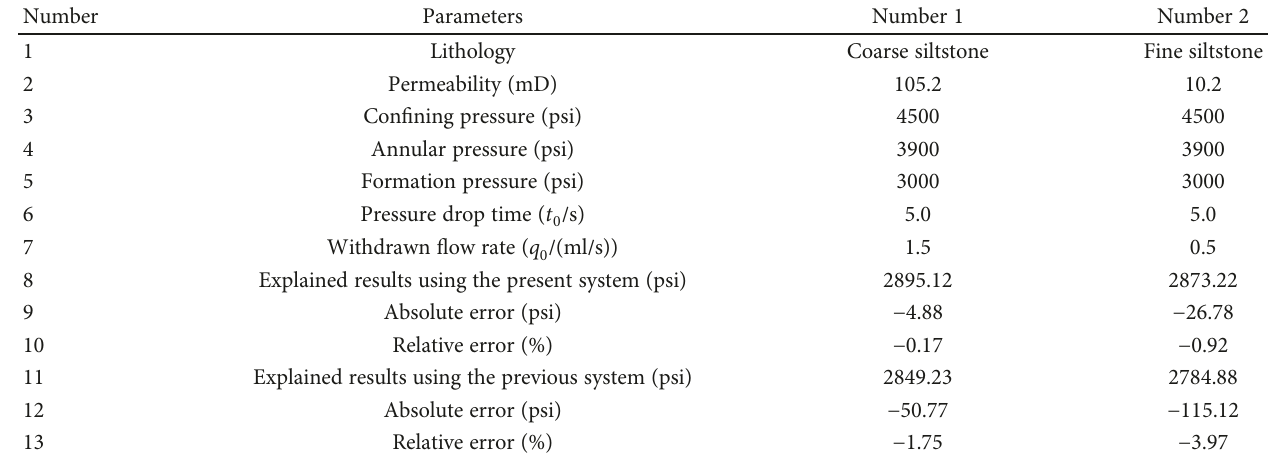
Table 3: Explained results of formation